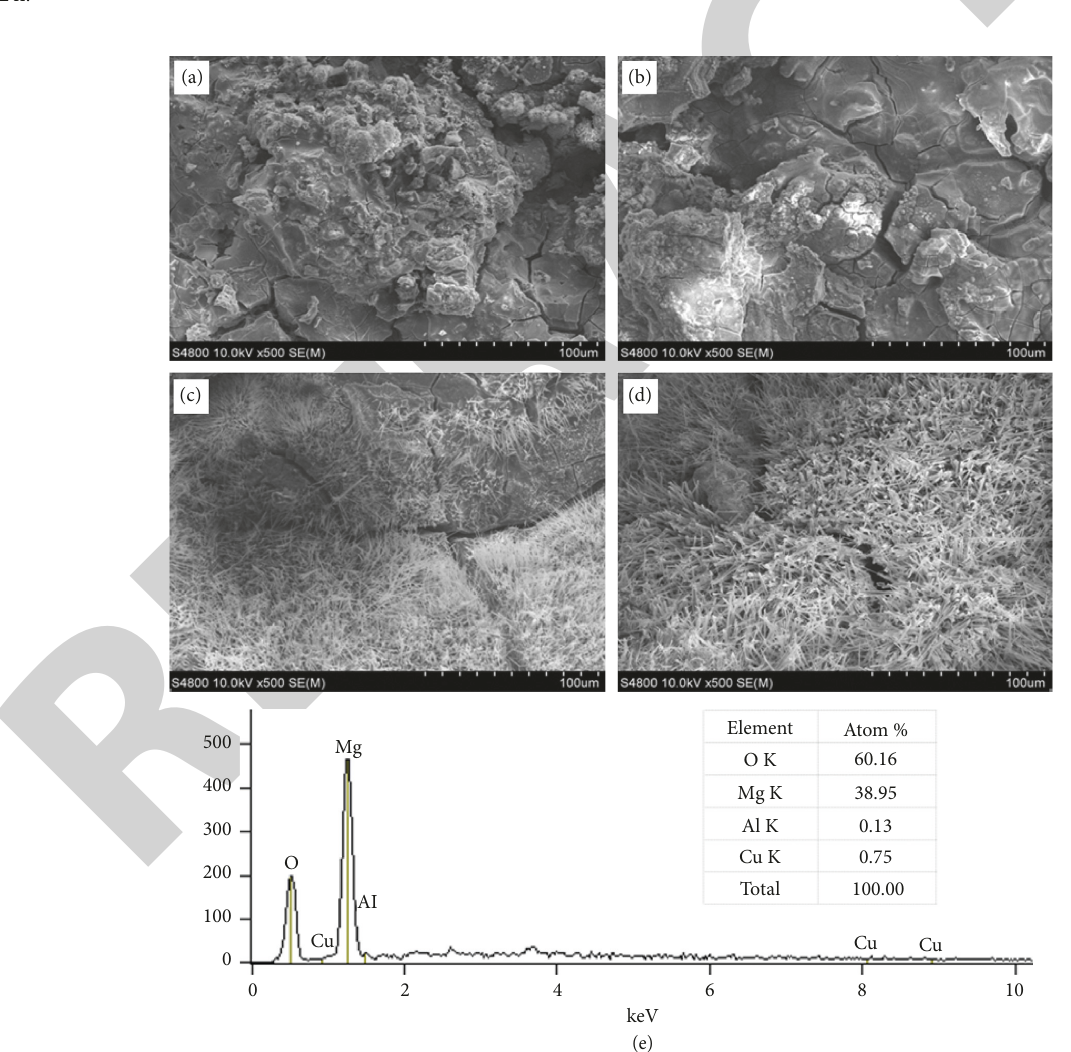
Figure 4: Surface SEM images of the as-cast (a) AC02 alloy immersed for 2h, (b) AC32 alloy immersed for 4h, (c) AC52 alloy immersed for 4h, and (d) AC92 alloy immersed for 13h in 3.5% NaCl solution. (e) EDS analysis of the degradation products on the surface of as-cast